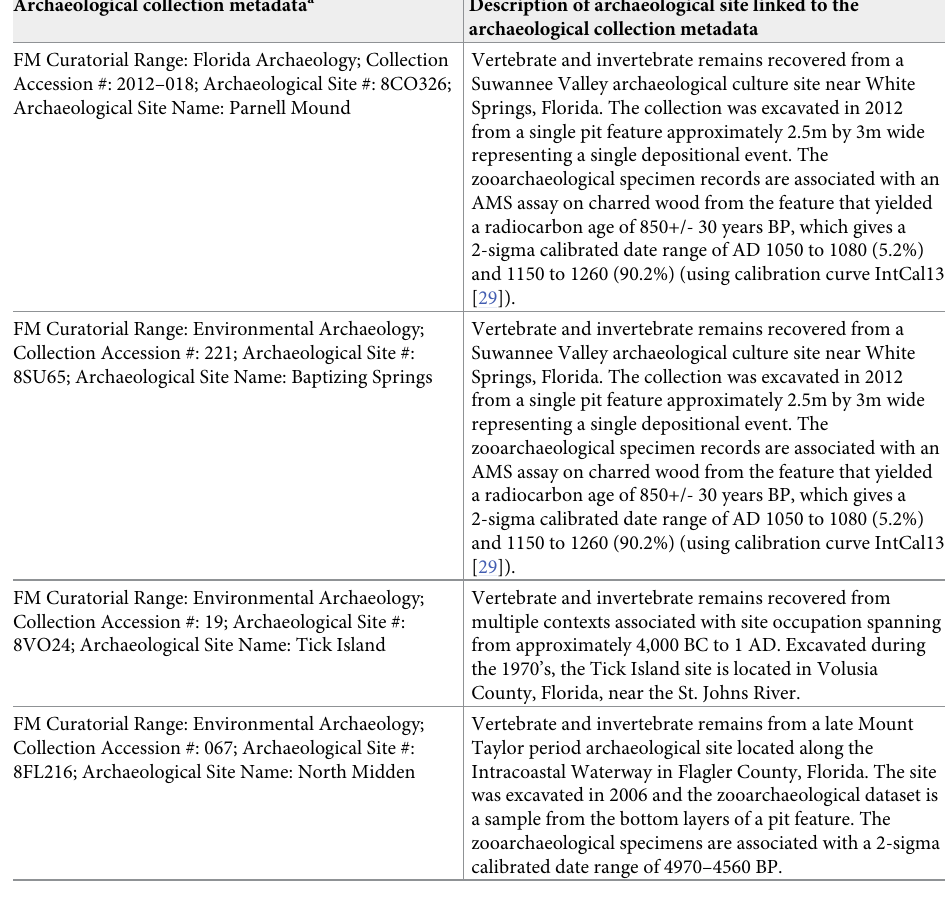
Table 1. Exemplar ZooArchNet datasets published in VertNet with links to Open